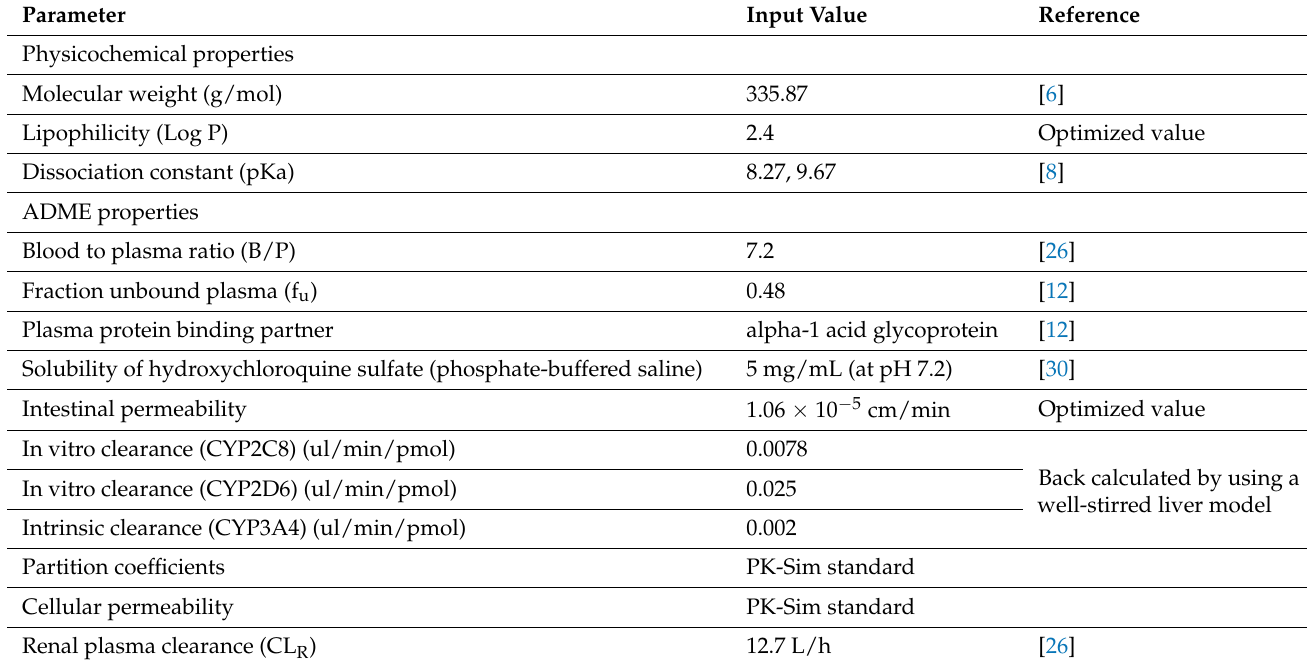
Table 2. Drug-related parameters that will be used in PK-sim software for the development of the PBPK model for